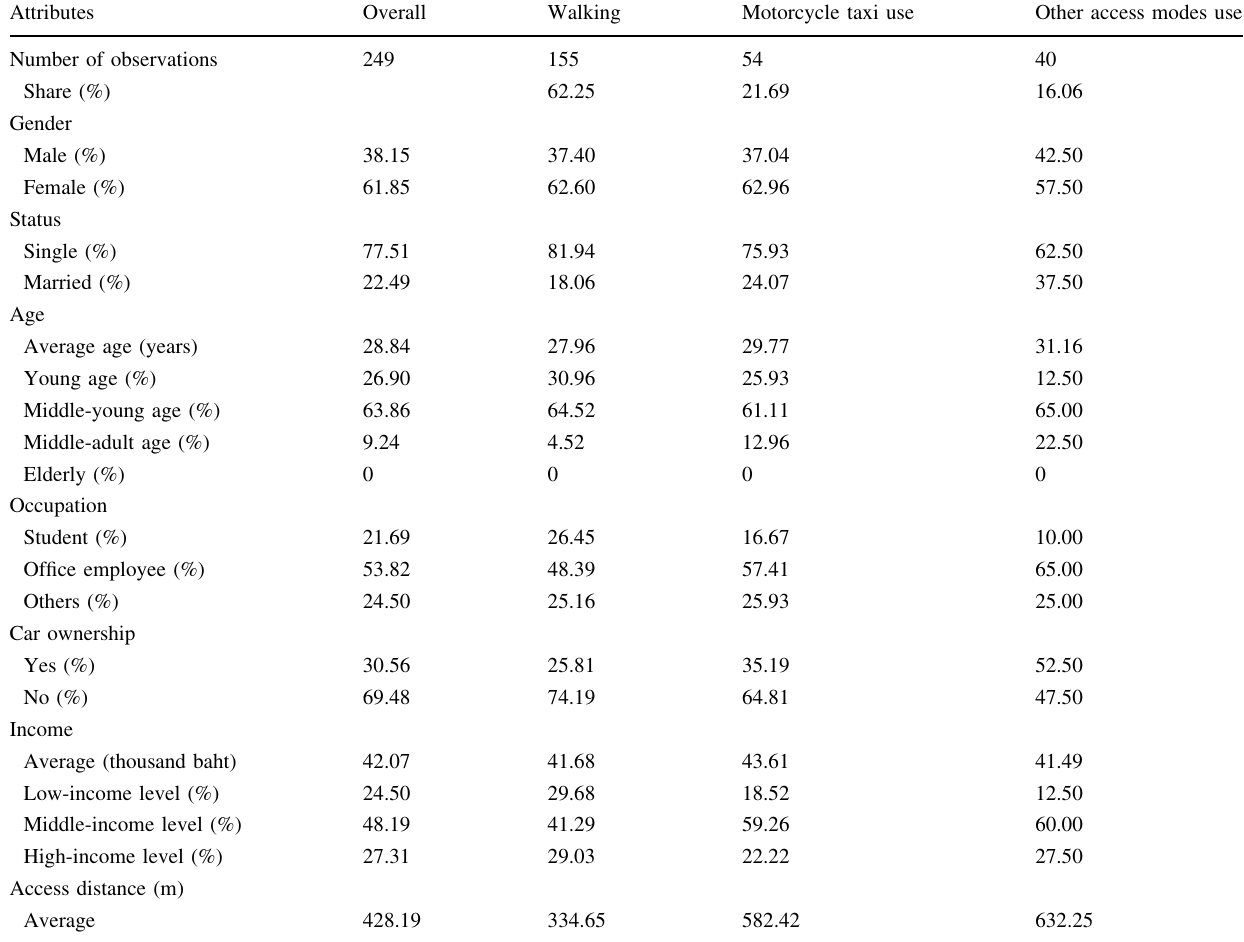
Table 1 Summary of respondents’ characteristics Attributes Overall Walking